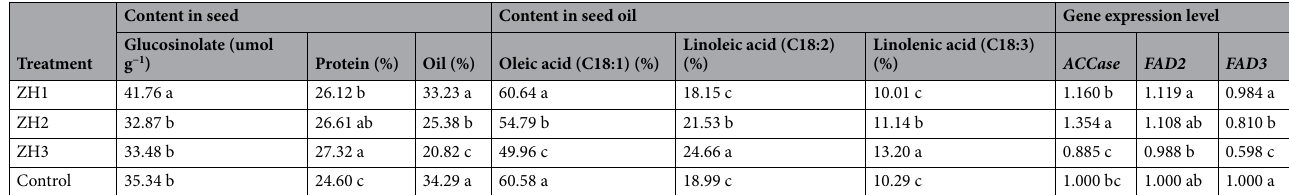
Table 8. Influence of the shading treatments on seed quality and gene expression of the key enzymes related to fatty acids